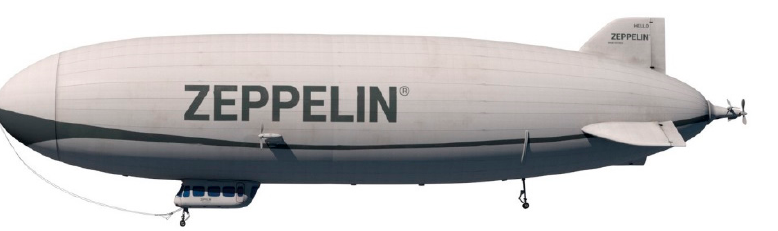
Figure 7. Layout of route planning simulation software developed for multi-mission-point route planning. After selecting the "Multi-Mission Points" mode, the user can click "Set Mission", then click on the map to set the coordinates of the multi-mission points, and finally click "Generate ". And the optimal route will be displayed on the map.